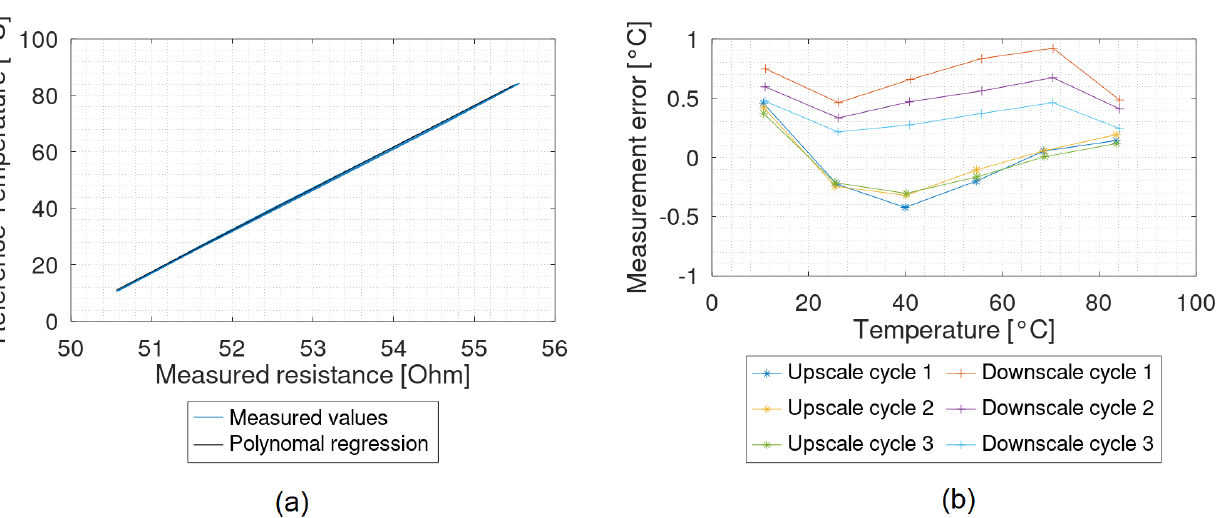
Figure 4. Course of temperature and relative humidity of the climate chamber. The cycles were se- lected according to IEC 61928-2.